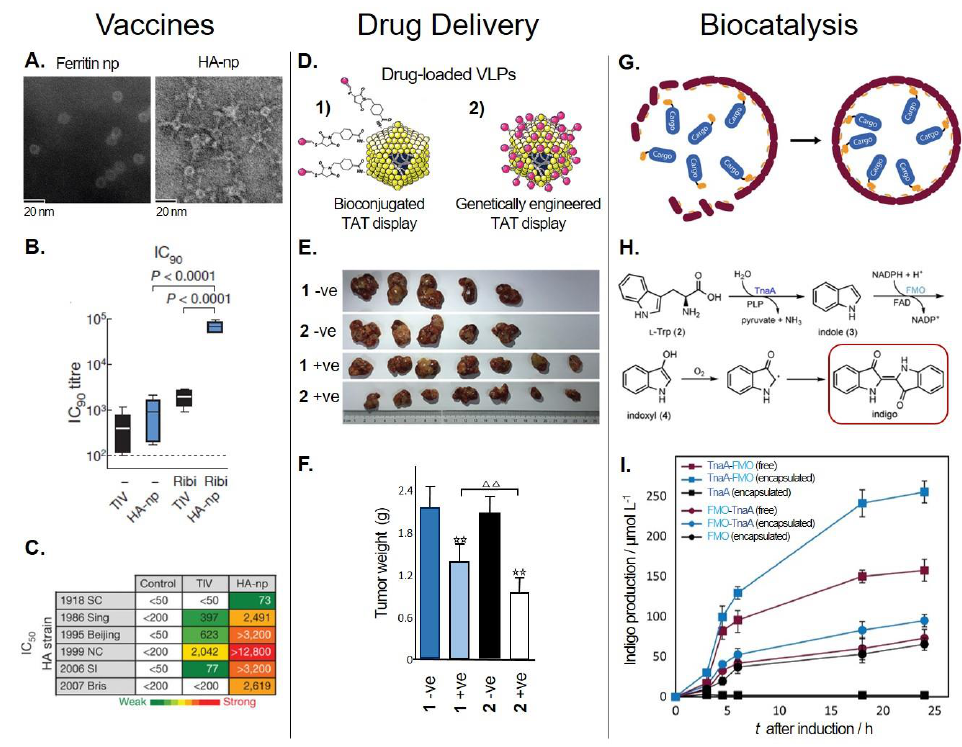
Figure 3. Examples of the bioapplications of PNPs. ( Left panel ) Vaccines: Development of a PNP-based influenza vaccine . ( A ) Transmission electron microscopy (TEM) image showing unmodified ferritin nanoparticles (np) (left) and modified ferritin np with visible hemagglutinin (HA) spikes (HA-np) (right). ( B ) Comparison of the immunogenicity (in mice) of trivalent inactivated influenza vaccine (TIV, control) or HA-np, without ( − ) or with adjuvant (Ribi) . Neutralization titers (IC 90 ) were determined by measuring the concentration of antibody required to inhibit viral entry by 90%. ( C ) against a range of H1N1 pseudotyped influenza viruses. Heat map is a colored gradient, from green (weak) to yellow to red (strong), reflecting the neutralization strength. Adapted with permission of